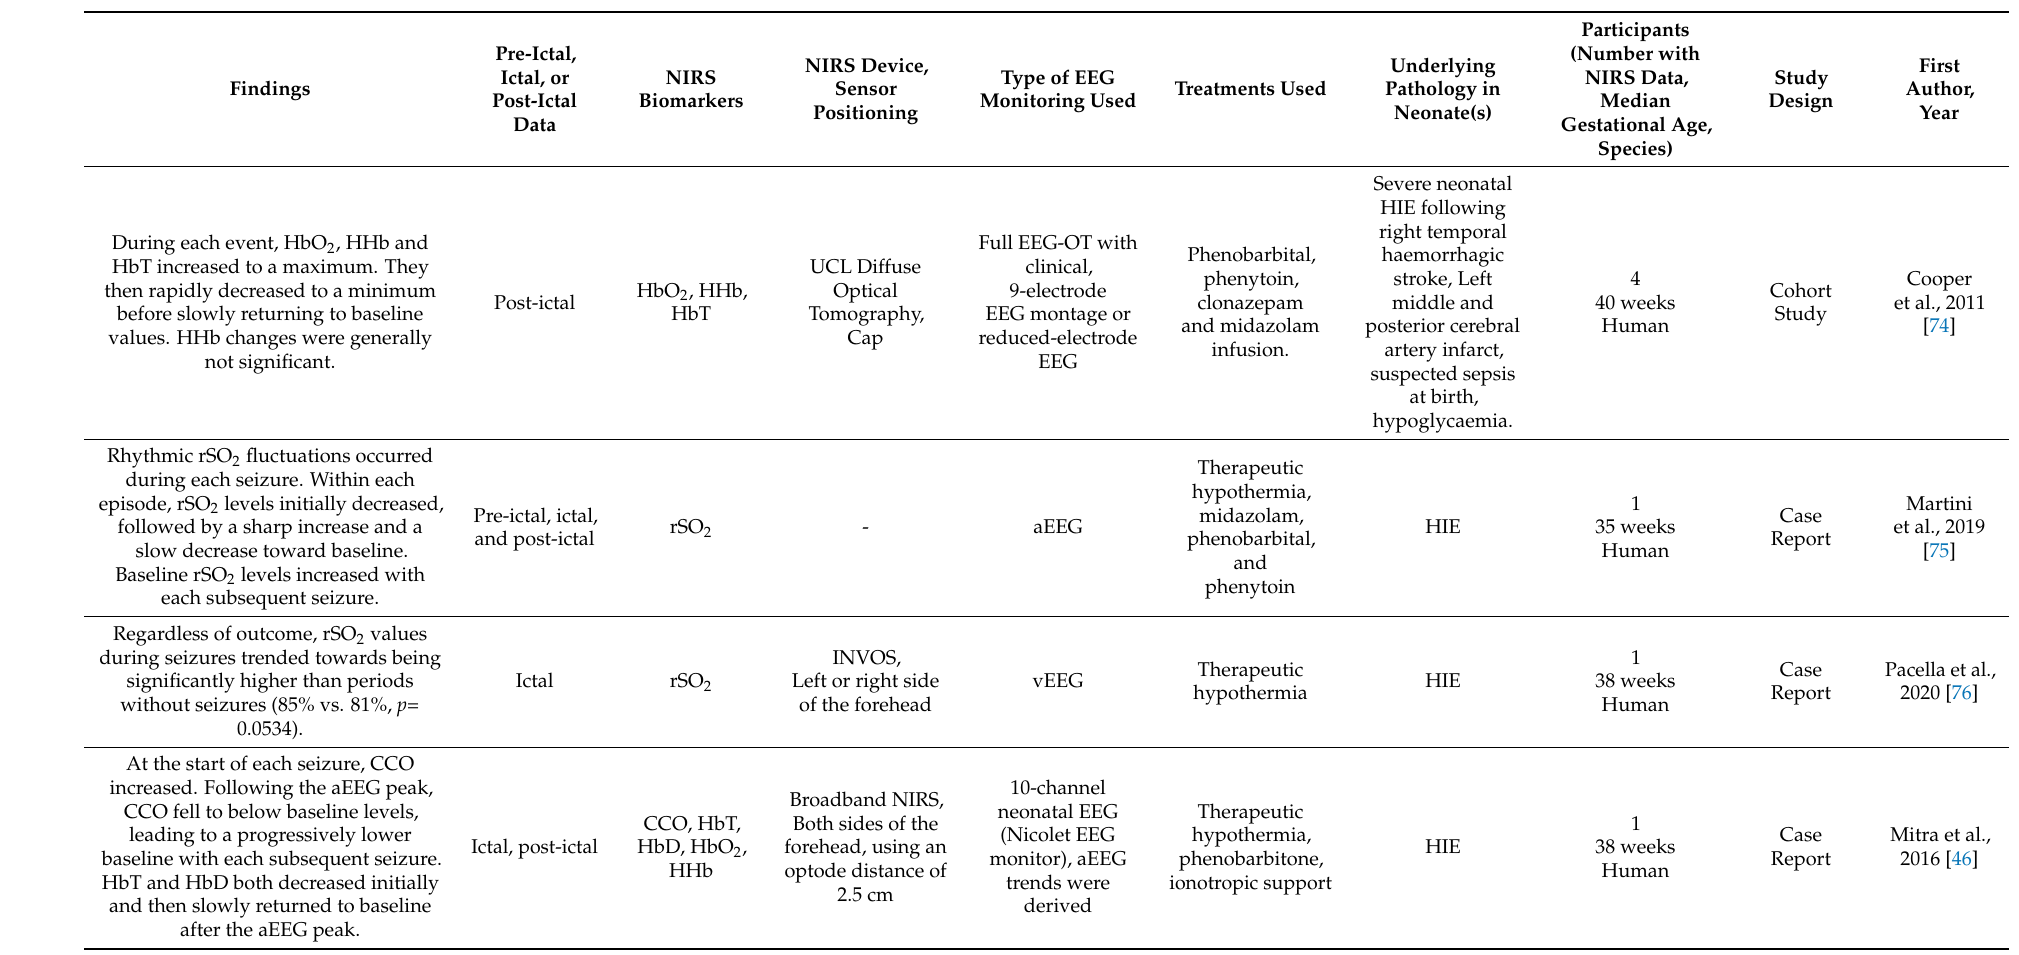
Table 3. Clinical data extracted from the included